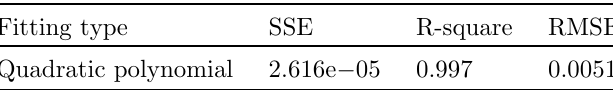
Table 10. Results of modi fi ed function fi tting.